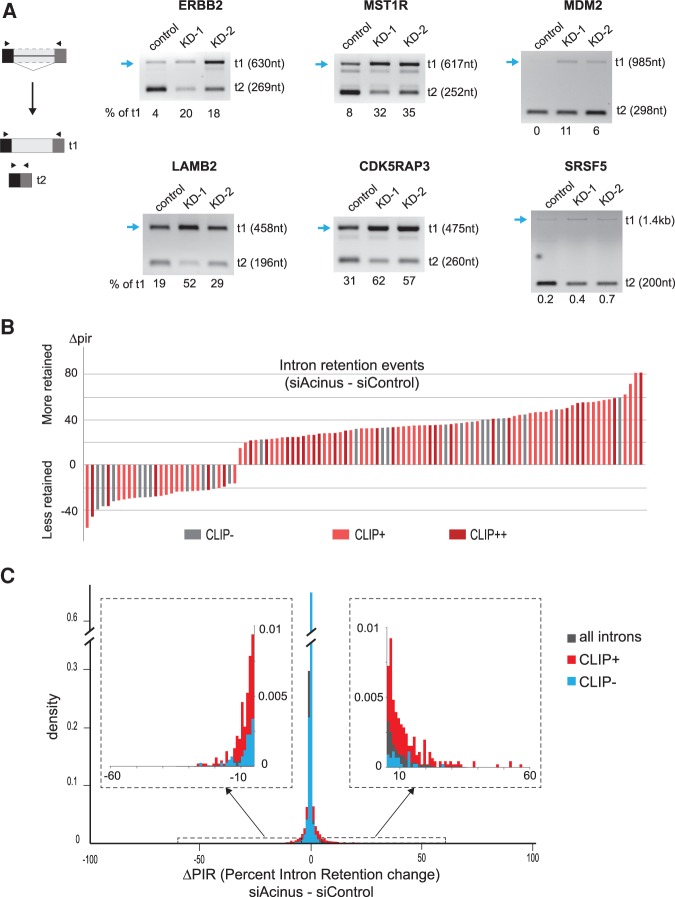
Intron retention changes mediated by Acinus. (A) Validation of intron retention changes for the ERBB2, MST1R, MDM2, LAMB2, CDK5RAP3, and SRSF5 transcripts in Acinus-depleted cells using two distinct siRNAs. The blue arrow indicates the isoform showing an increase in Acinus-depleted cells. The proportion of transcript t1, corresponding to the longest isoform, was estimated after quantification of the transcript's abundance by an Agilent Bioanalyzer. (B) Plot showing the Δpir (difference of intron retention level) for the intron retention events. Introns bound by Acinus are in red (CLIP+: in two out of three Acinus iCLIP and CLIP++: in all three iCLIP experiments). (C) Histogram showing the density of introns depending on their change in intron retention level (Δpir) in the RNA-seq data. The analysis was done on introns with reliable intron retention levels: 89,752 for all introns, for 4557 CLIP+ introns, and for 4461 CLIP− introns. The inside panels are zoomed-in views of the plot for a Δpir in the ranges (−60, −5) and (5:60).